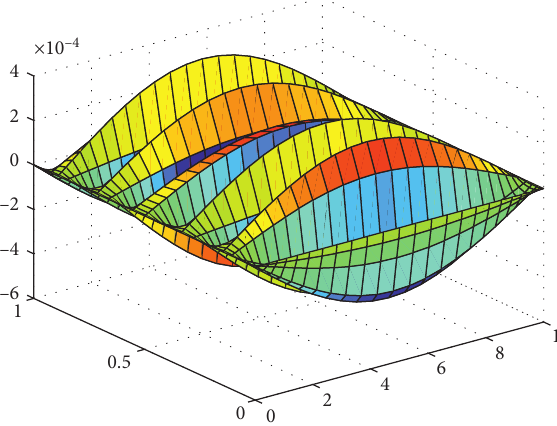
Figure 6: Errors of deflection with quasi-equidistant nodes m � n � 28 and d Table 5: Convergence rate of deflection with equidistant nodes d